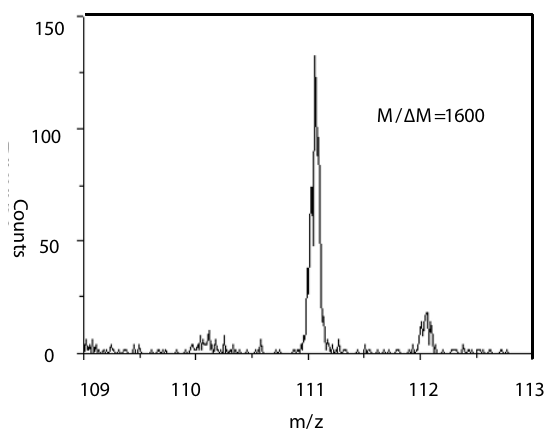
Figure 1. Mass spectrum of PFAN molecules recorded with a photoionization energy of 4.66 eV (266